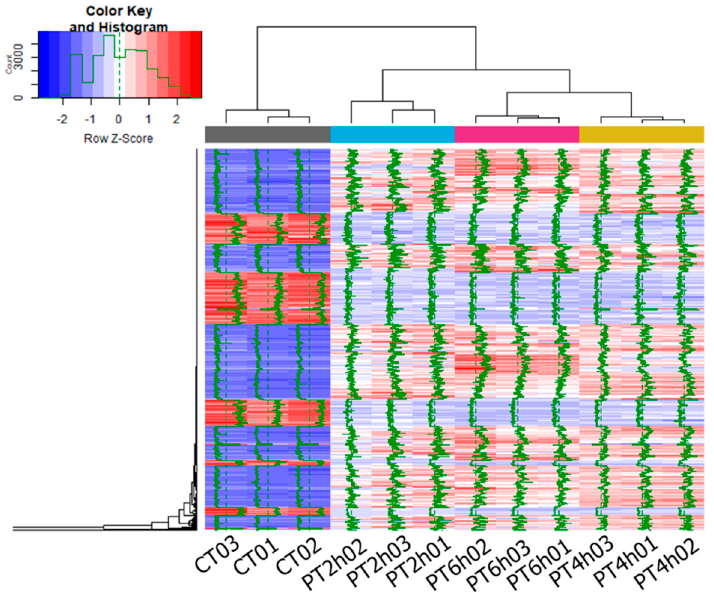
Figure 3. Heat map of DEGs. This figure shows gene expression profiles of common DEGs expressed in each experimental group.